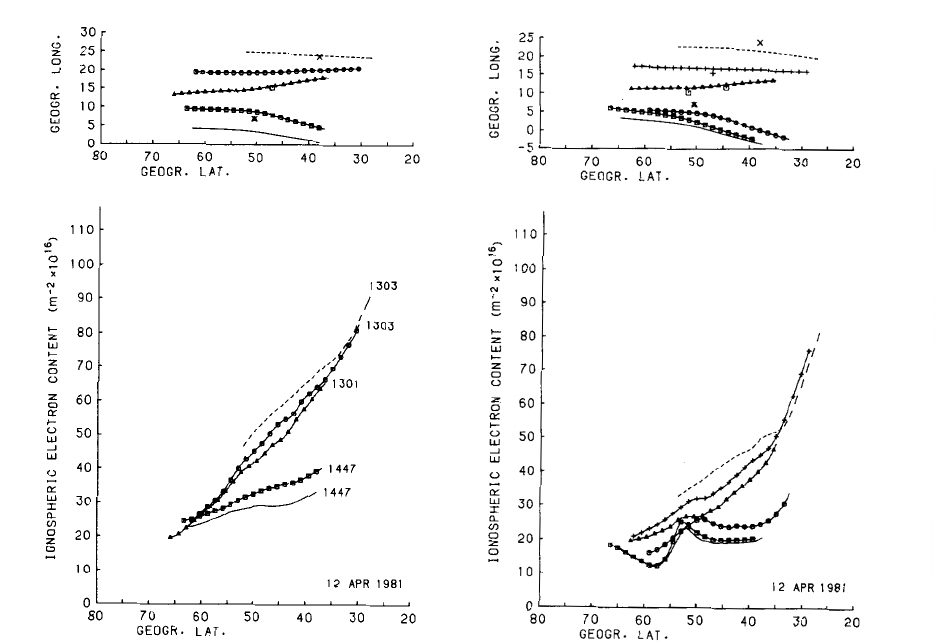
Fig. 9.8. Example for a regional negative storm effect (Leitinger et al., 1984). Latitude dependence of vertical electron content from the Differential Doppler effect on the 150/400 MHz signals of Navy Navigation satellites (NNSS). April 12, 1981, early afternoon ( left ) and late afternoon ( right ). Upper panels: maps of ionospheric points in a height of 400 km and receiving station locations (crosses). Receiving stations: E ffelsberg (50.5°N, 6.9°E), L indau (51.6°N, 10.1°E), B ologna (44.6°N, 11.7°E), G raz (47.1°N, 15.5°E), D ionysos (38.1°N, 23.9°E). Local time for reaching the ionospheric points in 42.5°N and station symbols: (left hand side) E – solid, 14:53; G – squares, 15:11; E – triangles, 14:07; G – circles, 14:17; D – dashed, 14:33. (Right hand side) E – solid, 17:36; L – squares, 17:39; B – circles, 17:51; E – triangles, 16:48; G – plus signs, 17:02; D – dashed,